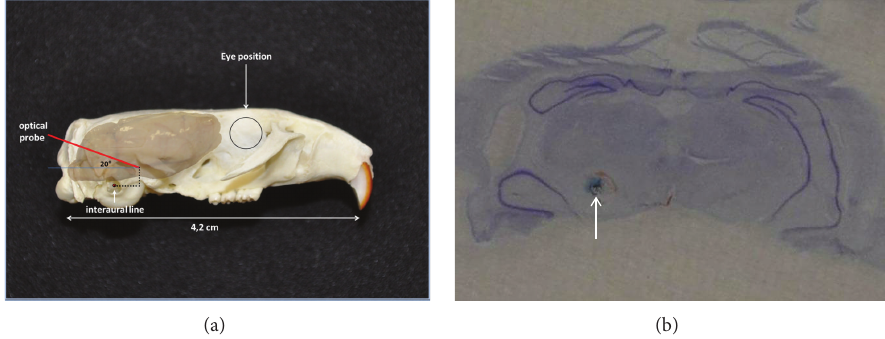
Figure 1: Schematic representation of the transcerebellar trajectory of the optical probe implanted in the rat substantia nigra . (a) The final coordinates of the probe tip were AP +4.0, L 2.0, and DV 2.5 from the interaural line, according to the Rat Brain Atlas of Paxinos and Watson. The black circle represents the eye position with respect to the brain. (b) Coronal section (30 𝜇 m thick) stained with Cresyl Violet to evaluate the position (arrow) of the optical probe within the